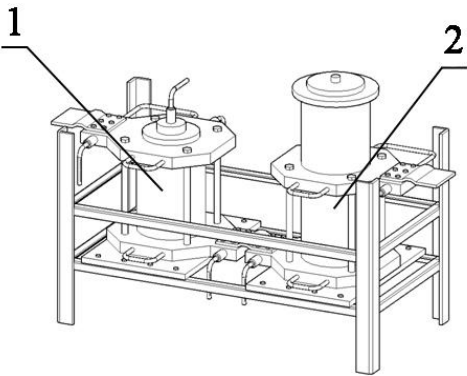
Figure 2. Structure of the separated type pyro-breaker: ( 1 ) commutation section; ( 2 ) insulation section.